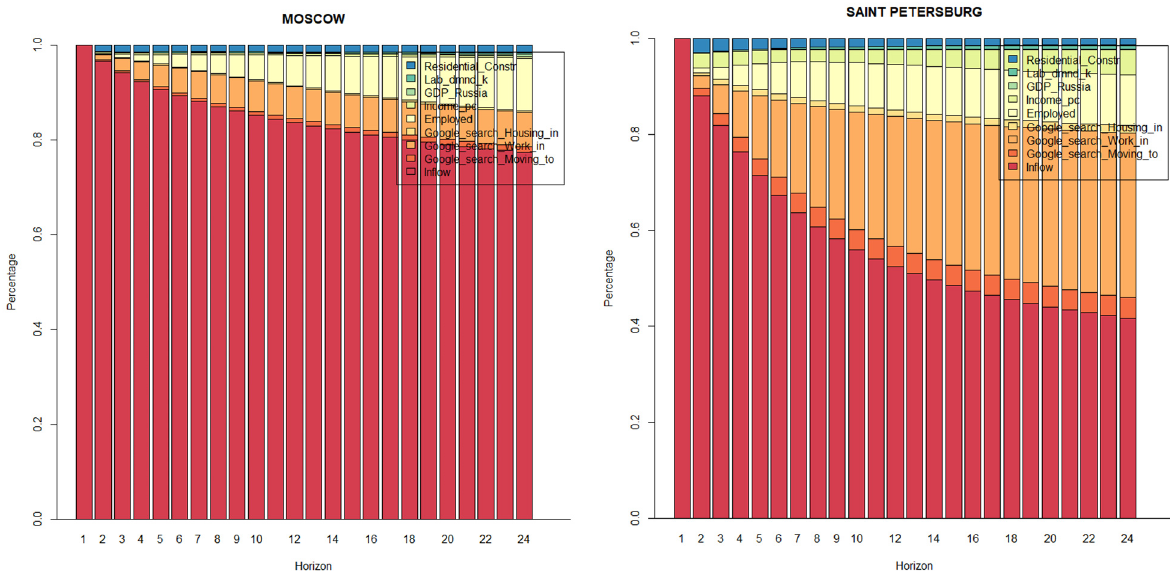
Figure 5. Forecast error variance decomposition of the VAR (1) with centered seasonal dummies: Moscow ( left panel ); Saint Petersburg ( right panel ).